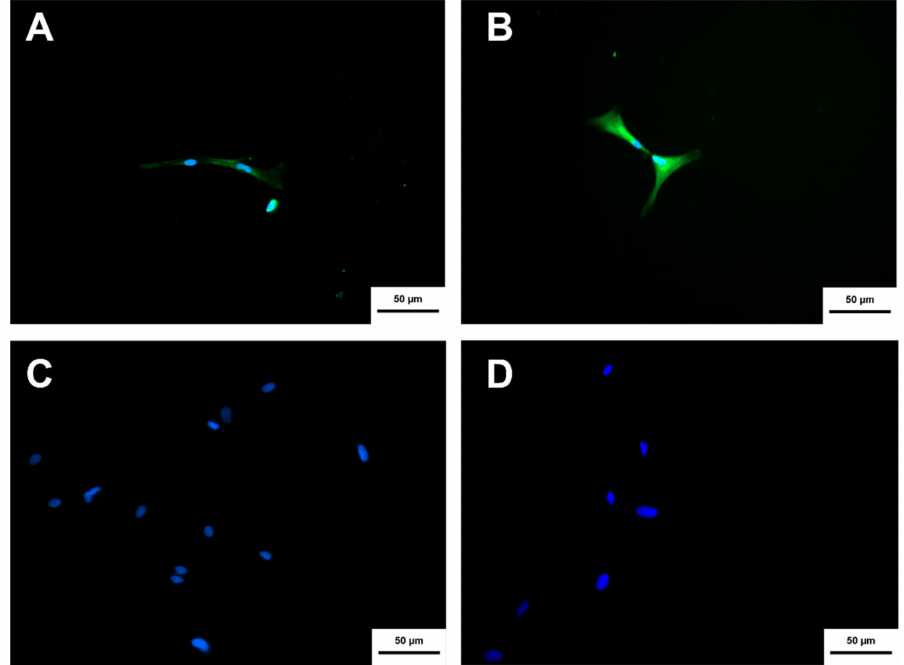
Figure 9. Cholinergic differentiation immunocytochemistry of NPCN + cells derived from MSC-UCB. ( A ) MSC-UCB labeling using the anti-ChAT antibody (FITC). ( B ) MSC-UCB labeling using the anti- ßIII-TUBULIN antibody (FITC). ( C , D ) represent the negative controls (MSC-UCB not differentiated) for both markers anti-ChAT and anti-ßIII-TUBULIN, respectively Hoechst was used for labeling the nuclei. (Inverted fluorescence microscope with increase of × 100, Axio Vert A1, Carl Zeiss, Oberkochen,